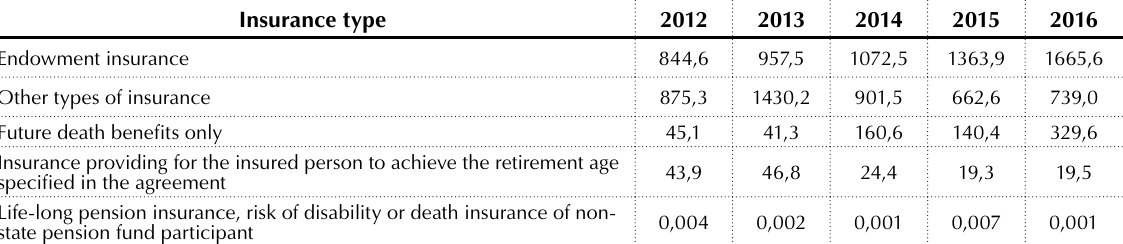
Table 2. Life insurance services in Ukraine in terms of net insurance premiums in 2012–2016, million UAH